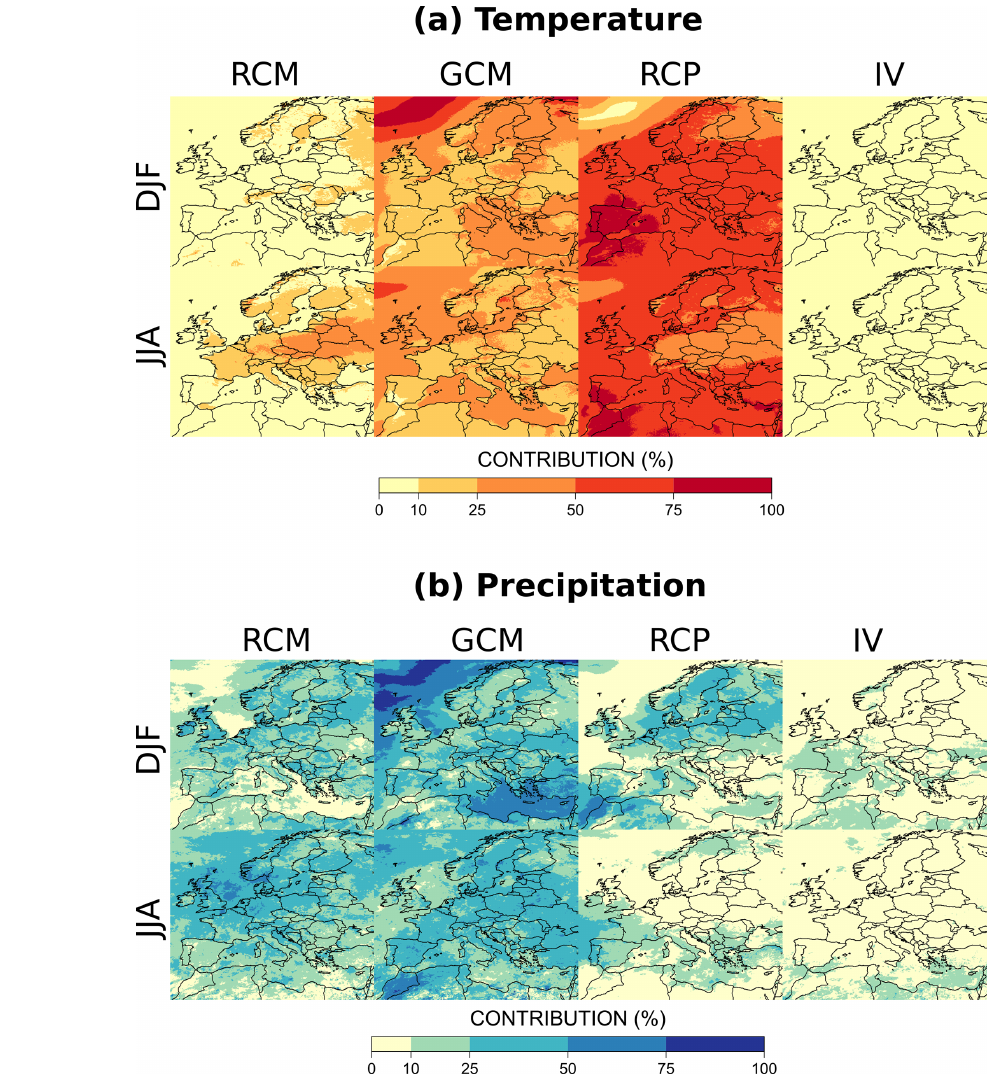
Figure 8. Fraction of total variance explained by the main sources of uncertainty: RCM, GCM, RCP scenario, and internal variability (IV) for (a) absolute temperature changes and (b) relative precipitation changes at the end of the 21st century (2071–2099) compared to the period